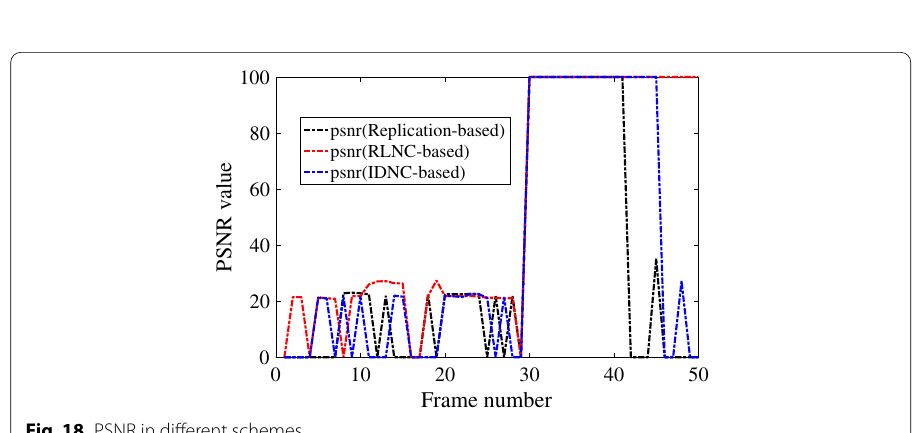
Fig. 18 PSNR in different